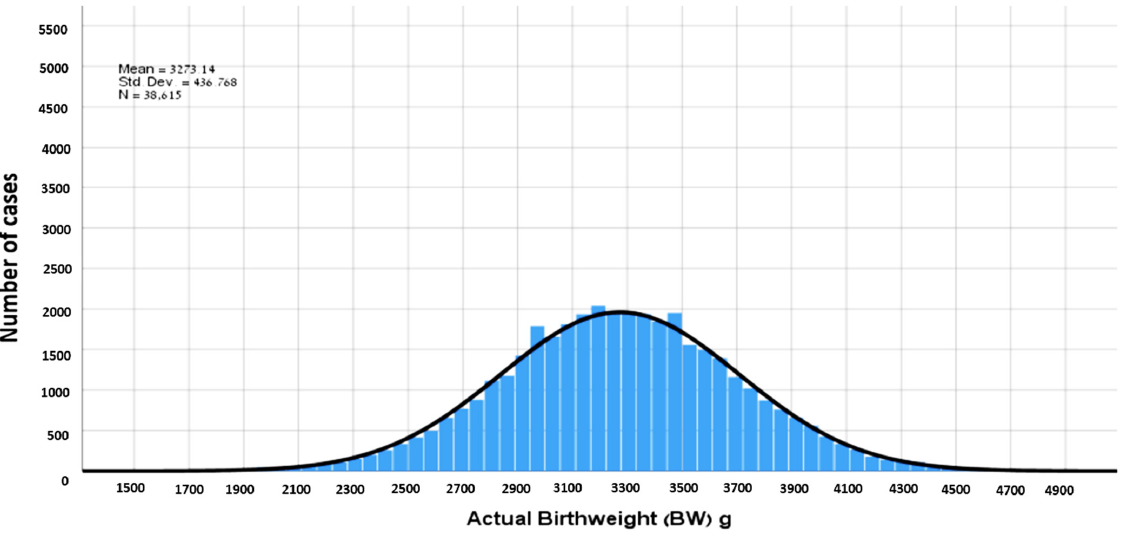
Figure 3. Distribution of actual birthweights.